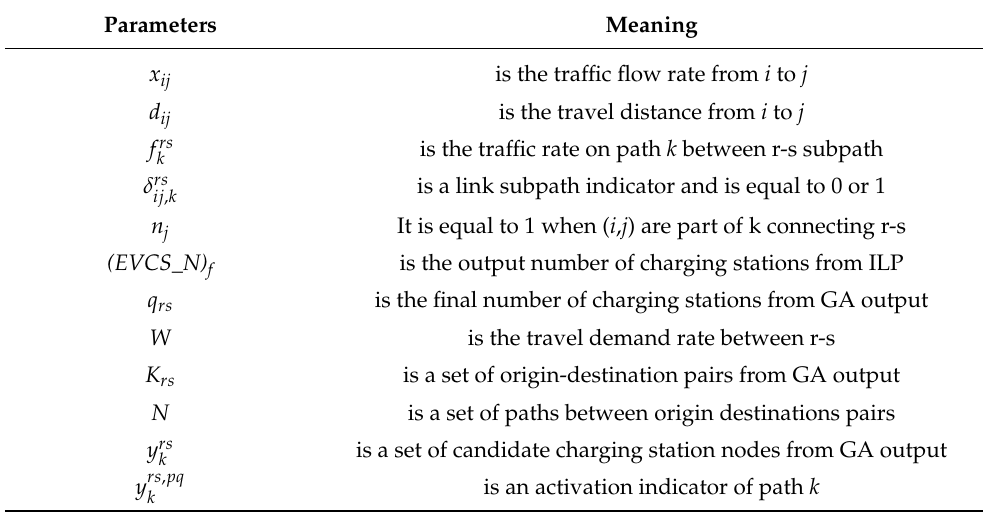
Table 3. List of ILP